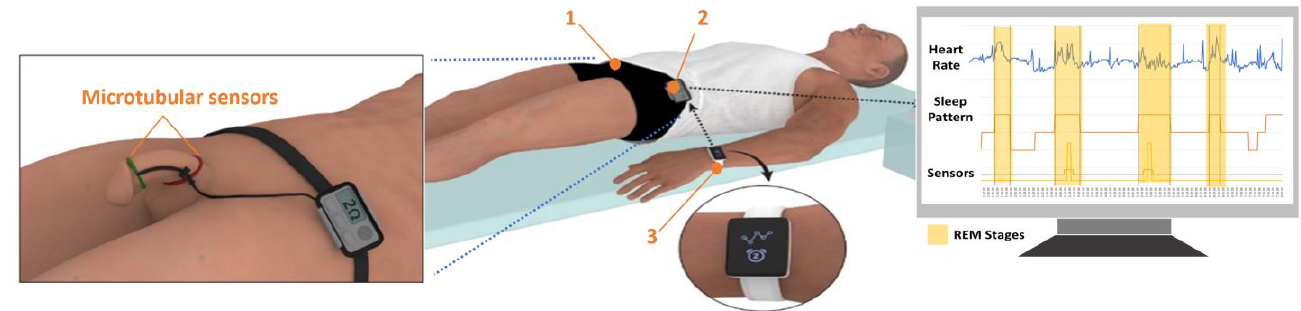
Figure 1. Illustration of the concept of EDSEN consisting of (1) a pair of microtubular sensors, (2) a wireless wearable detector, and (3) a smartwatch for REM sleep monitoring.